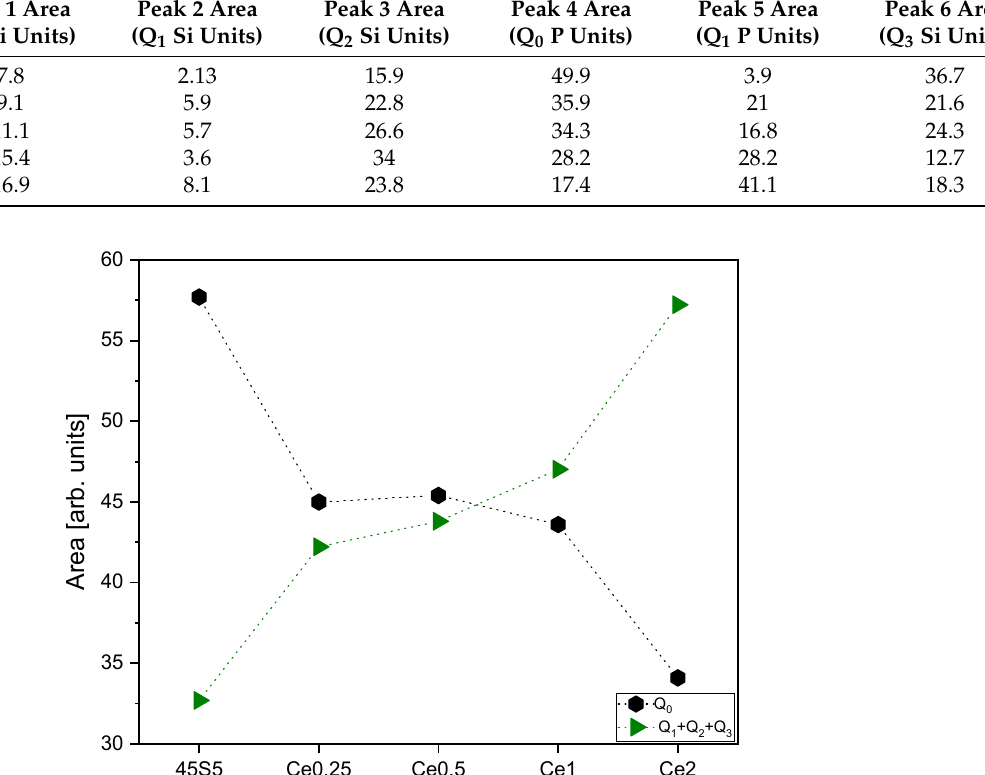
Figure 5. Sum of areas of Q 0 and Q 1 +Q 2 +Q 3 (NBOs) units of the 45S5, Ce0.25, Ce0.5, Ce1 and Ce2 samples.